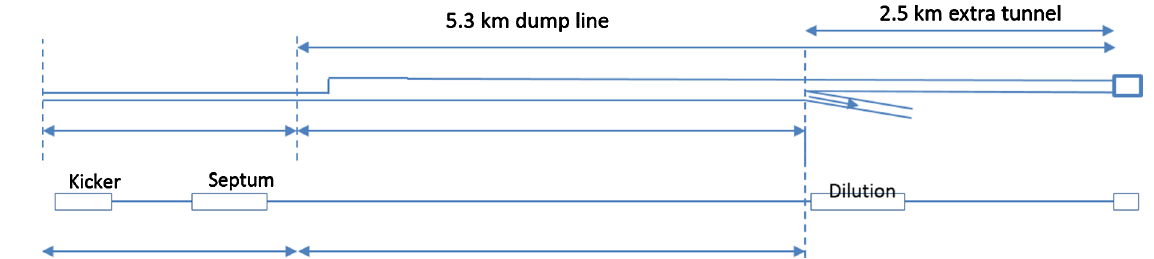
FIG. 10. Sketch of a dump tunnel downstream the collimation